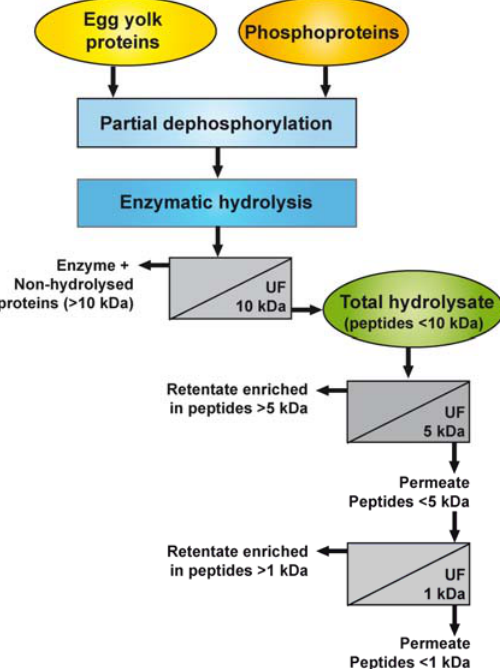
Figure 1. Schematic representation of the process used for the dephosphorylation of EYP and PPP, the production of enzymatic hydrolysates and their